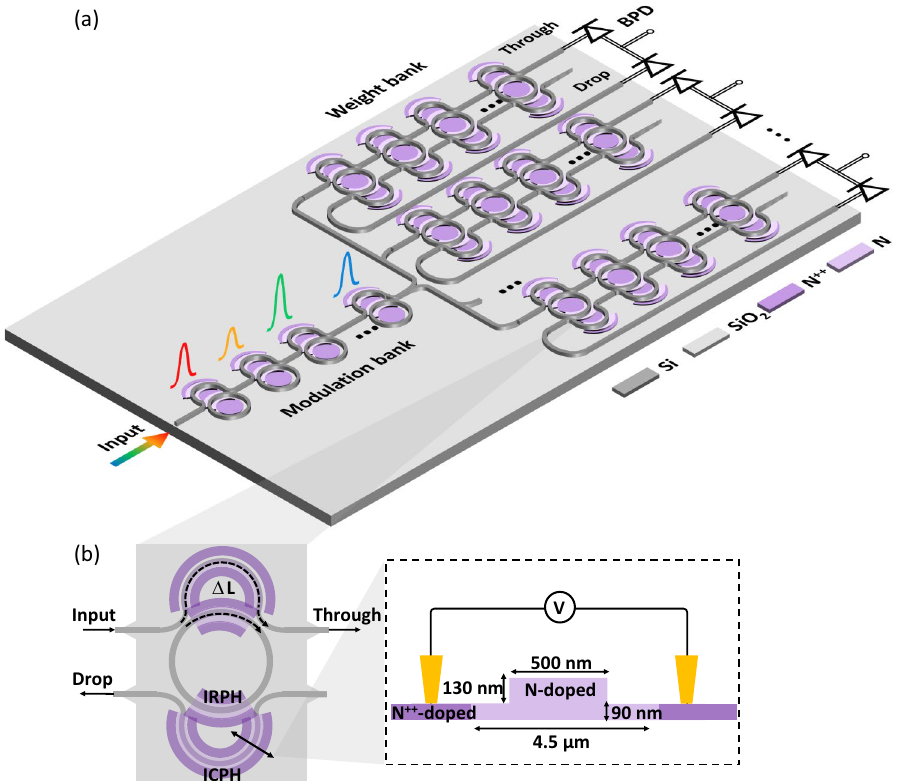
Figure 1. ( a ) Schematic of the proposed photonic processing system using IM-MRMs. For intensity modulation, WDM input light passes through two groups of IM-MRM arrays, as the multiplier set (modulation bank) and multiplicand set (weight bank), respectively. The modulated light at different wavelengths is then accumulated by the BPD at the readout. ( b ) Schematic of one add-drop IM-MRR filter and the cross-section of the doped waveguide, which forms ICPHs and IRPHs in the coupling region and the resonator region,